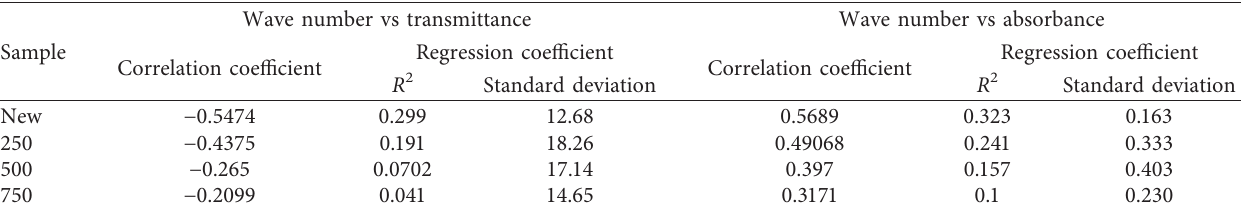
Table 8: Correlation and regression chart for wave number versus transmittance and